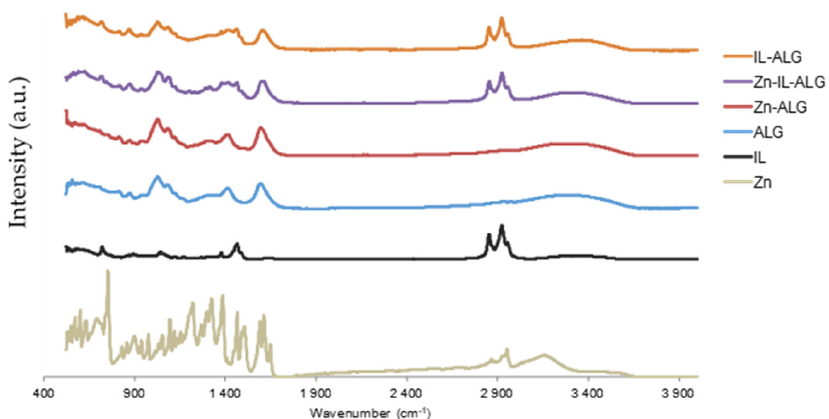
Figure 1. Infrared spectra of pure Zn(II)-AHBD catalyst (Zn), pure [Aliquat][Cl] (IL) and alginate aerogels: blank alginate aerogel (ALG), Zn(II)-AHBD-impregnated aerogel (Zn-ALG), aerogel impregnated with Zn(II)-AHBD and [Aliquat][Cl] (Zn-IL-ALG) and aerogel impregnated with [Aliquat][Cl] (IL-ALG).